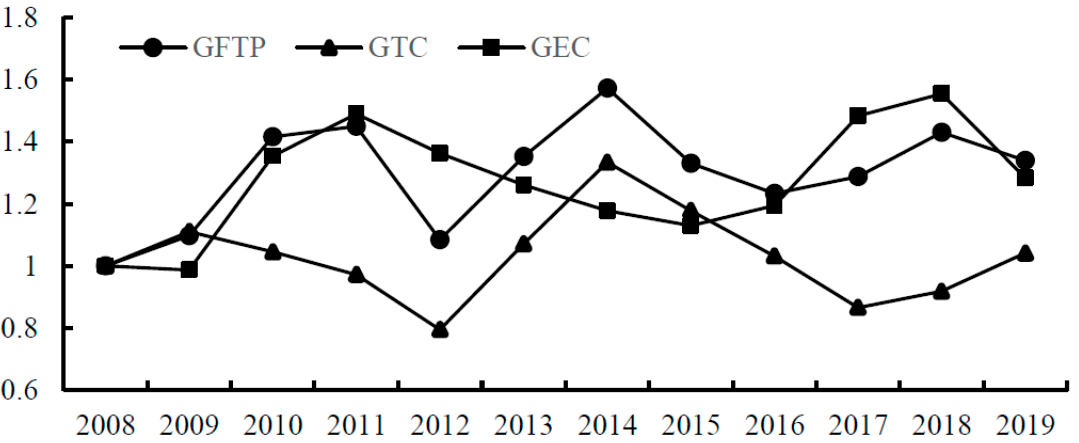
Figure 2. Citrus GTFP and its decomposition cumulative change. Table 2. Citrus GTFP and its decomposition change by